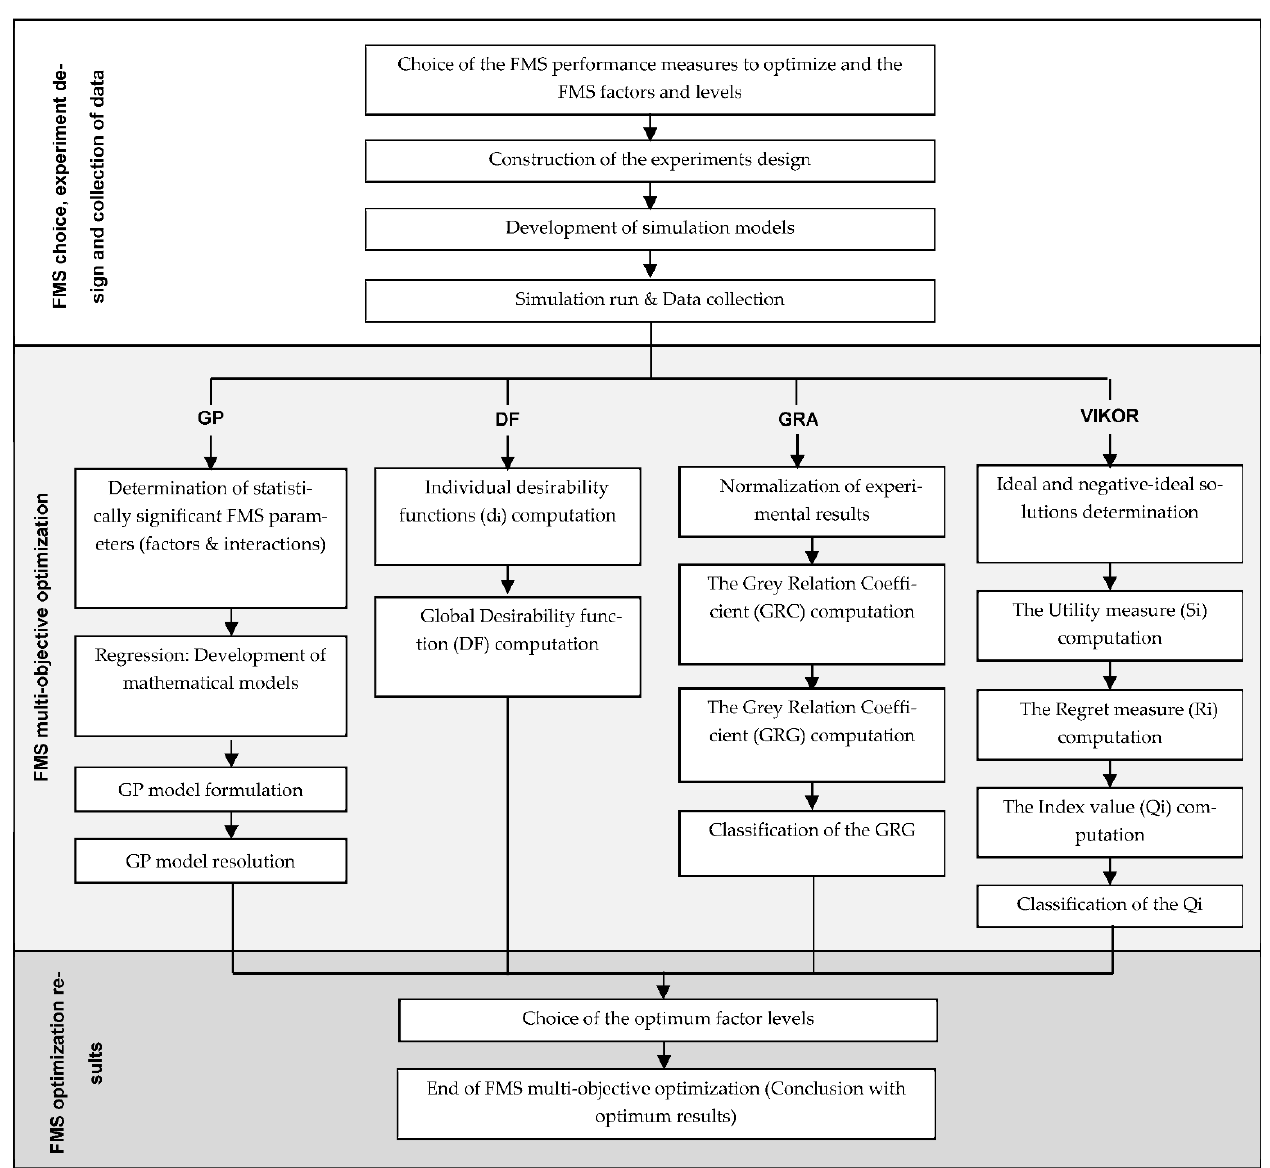
Figure 1. The major steps of the FMS optimization approach with multiple performance